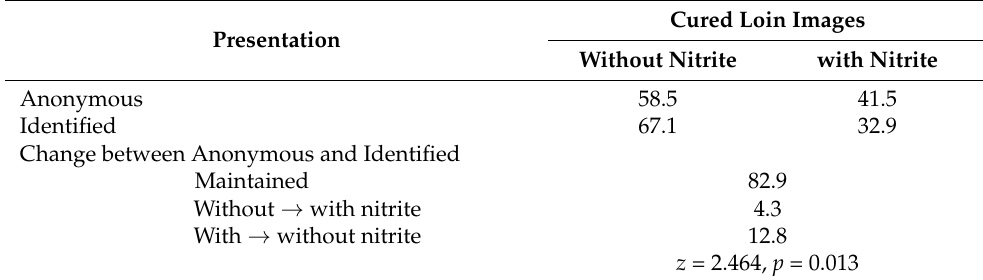
Table 5. Percentage of consumers considering the cured loins’ color to be more characteristic based on an observation of pairs 1 of online images in an anonymous test and after identification as having a carcinogenic additive or not ( n = 164